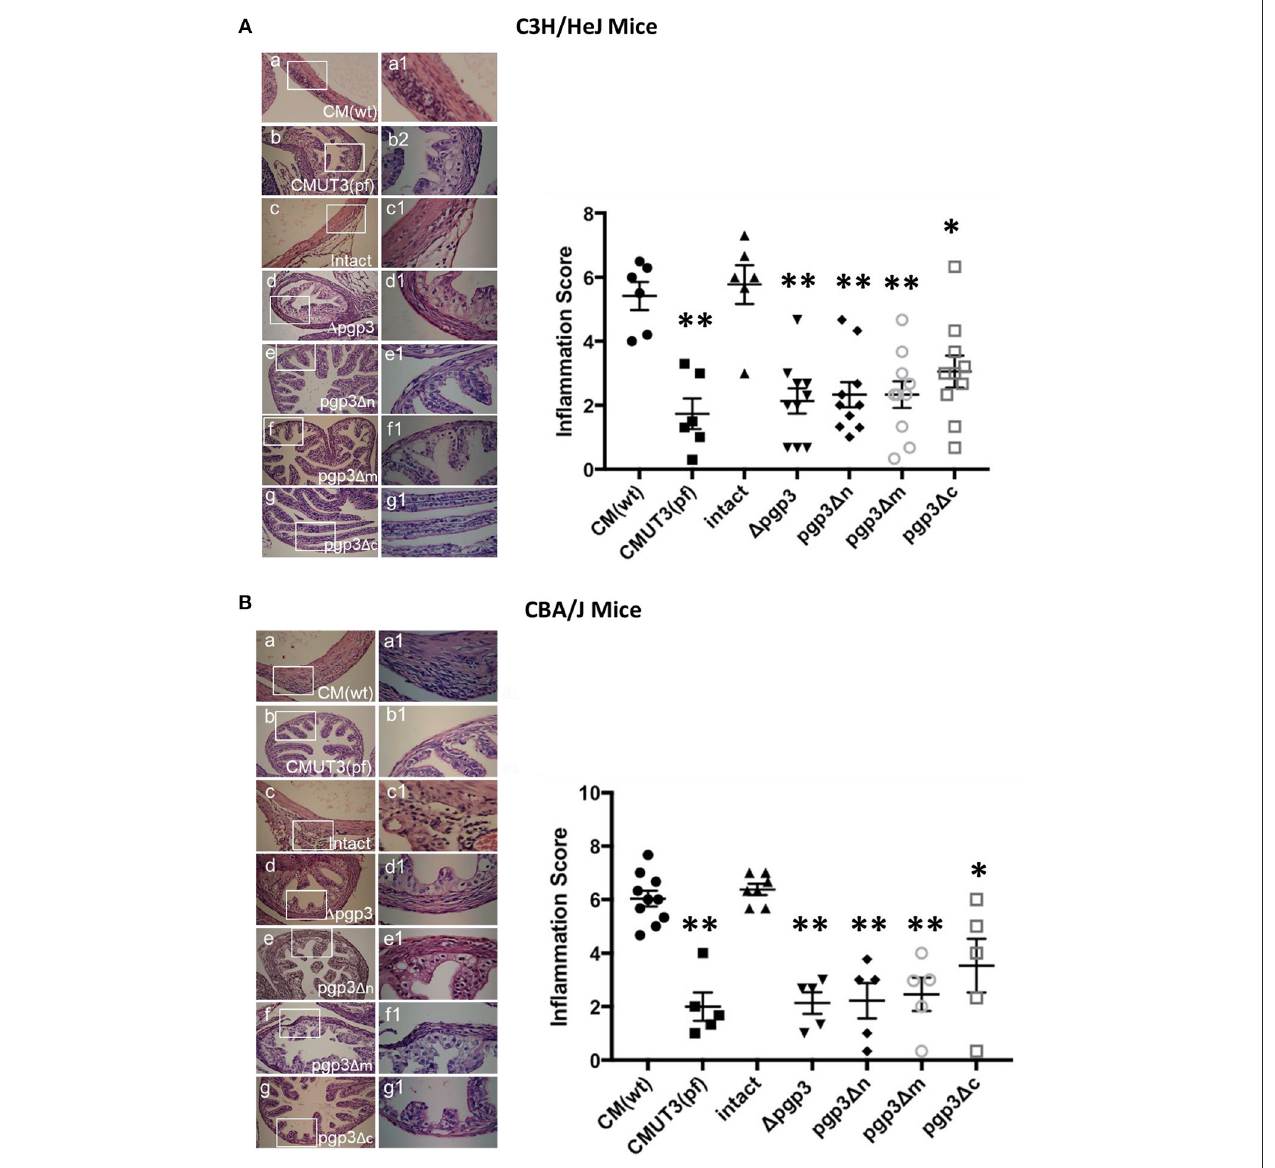
FIGURE 6 | Effect of Pgp3 domain deletion on chlamydia-inducing histopathology. Ovary/oviduct tissues from C3H/HeJ (A) or CBA/J mice (B) were harvested and subjected to hematoxylin and eosin staining to evaluate inflammatory cell infiltration and oviduct dilation. (a–g) Representative image from each group at 40 × magnification; (a1–g1) enlargements (100 × magnification) of the areas demarcated by white rectangles. Inflammatory cell infiltration was semi-quantified (right) using intact organisms as the control. WT and intact C. muridarum , but not the pgp3-domain-deficient mutants, induced severe oviduct dilation and inflammatory